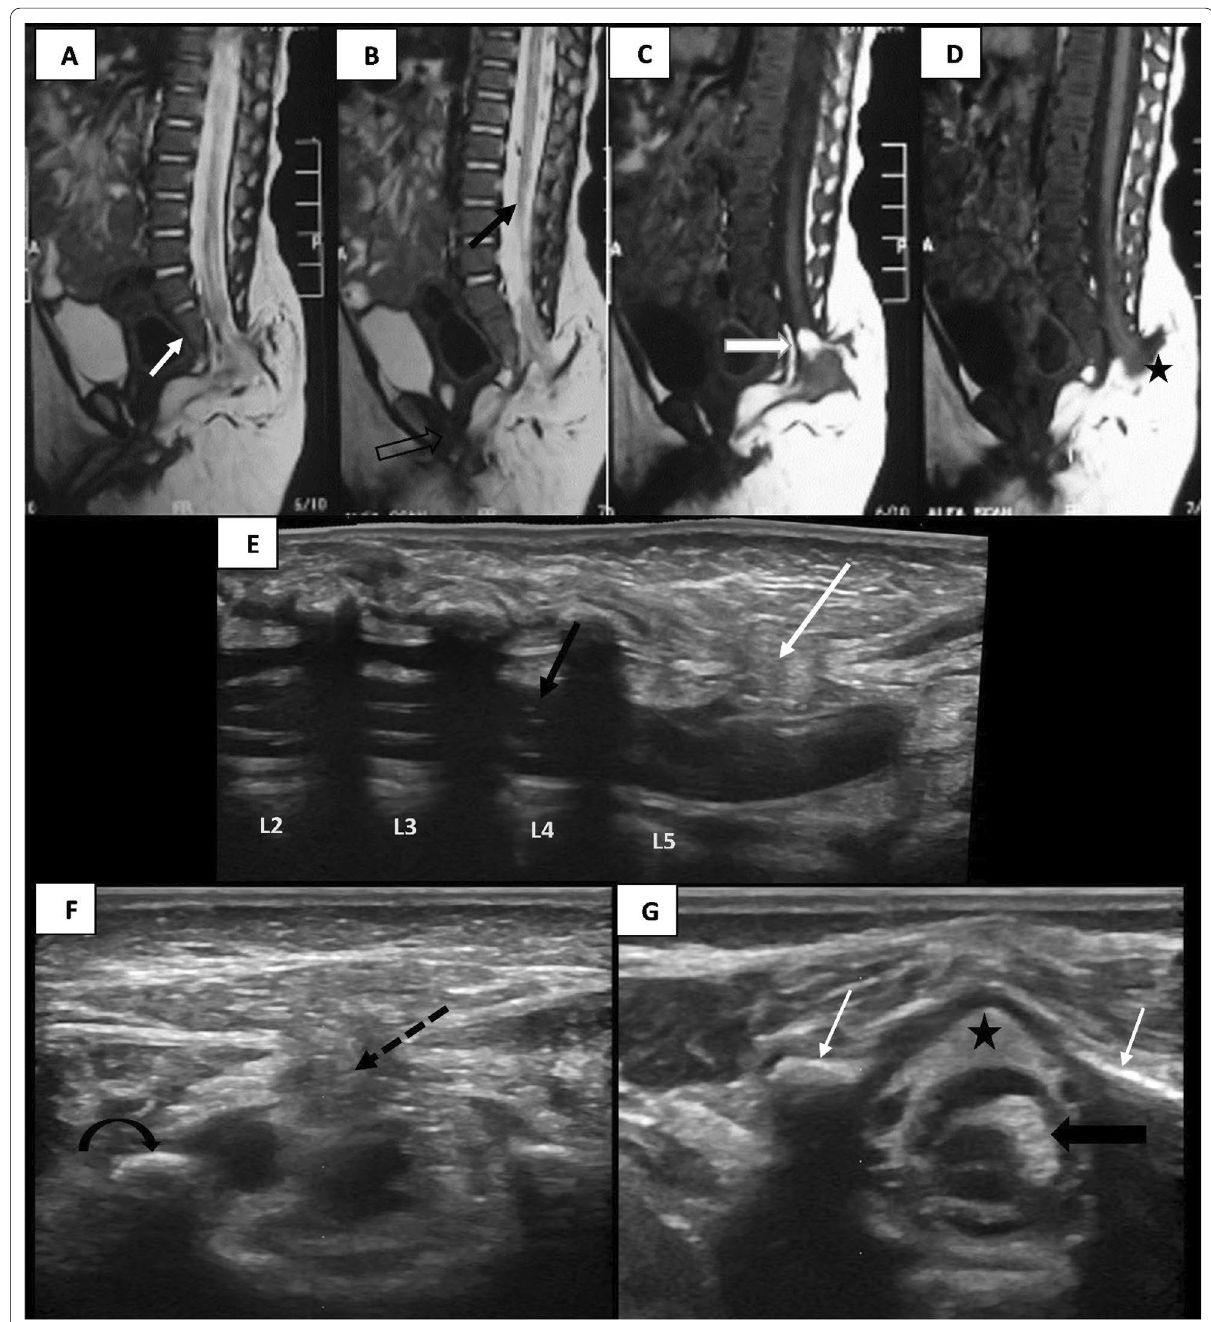
Fig. 2 One-month-old male infant presented with low back fatty swelling and ARM. A Sagittal T2WI showing agenesis of S3, 4, 5 sacral elements and coccyx in keeping with sacral agenesis type II (white arrow). B Midline sagittal T2WI showing low lying conus medullaris ending at level of L3–4 disk yet with normal tapering appearance (black arrow), note also evidence of high-level ARM; above puborectalis muscle, with rectourethral fistula (Black empty arrow). C Sagittal T1WI showing herniation of subcutaneous fat through dural defect into spinal canal (white arrow). D Sagittal T1WI showing lipoma-placode interface outside spinal canal (star). E Sagittal USG image showing conus medullaris tip at level of L4 (black arrow), with subcutaneous fatty mass seen herniating into spinal canal (white arrow). F Axial USG image showing herniation of neural placode (dashed arrow) outside the confinement of spinal canal (curved black arrow, lamina). G Axial USG image at level of L4 showing lamina (white arrows), epidural fat (star) and cauda equina nerves (black arrow). Type of spinal dysraphism: Lipomyelomeningeocele with partial sacral